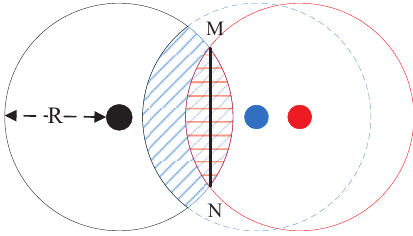
Figure 2. The diagrammatic sketch of Remarks 1 &